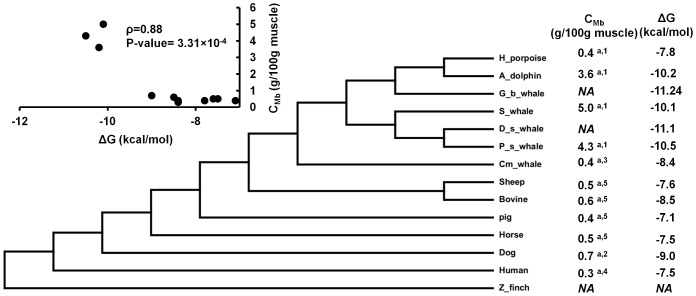
Divergence of cetaceans and the increase in Mb concentration by ∼10–20 fold.The experimental folding stability of apoMb is added to the difference in stability of holo and apoMb reported for horse heart Mb (2.7 kcal/mol). Stability is highly correlated with Mb concentration with correlation coefficient ρ = 0.88 and p-value = 0.000331. The Mb concentration has been measured in adorsi and in bpsaos muscle types. Data are taken from 1: [57], 2: [75], 3: [44], 4: [7] and 5: [76]. All the folding stabilities are taken from [14].